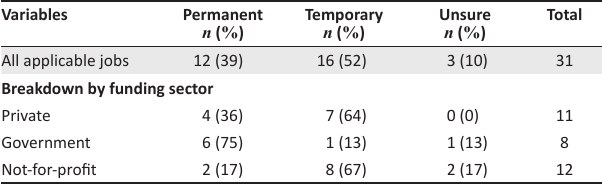
TABLE 4: Frequency: age range of speech and language therapy service users.